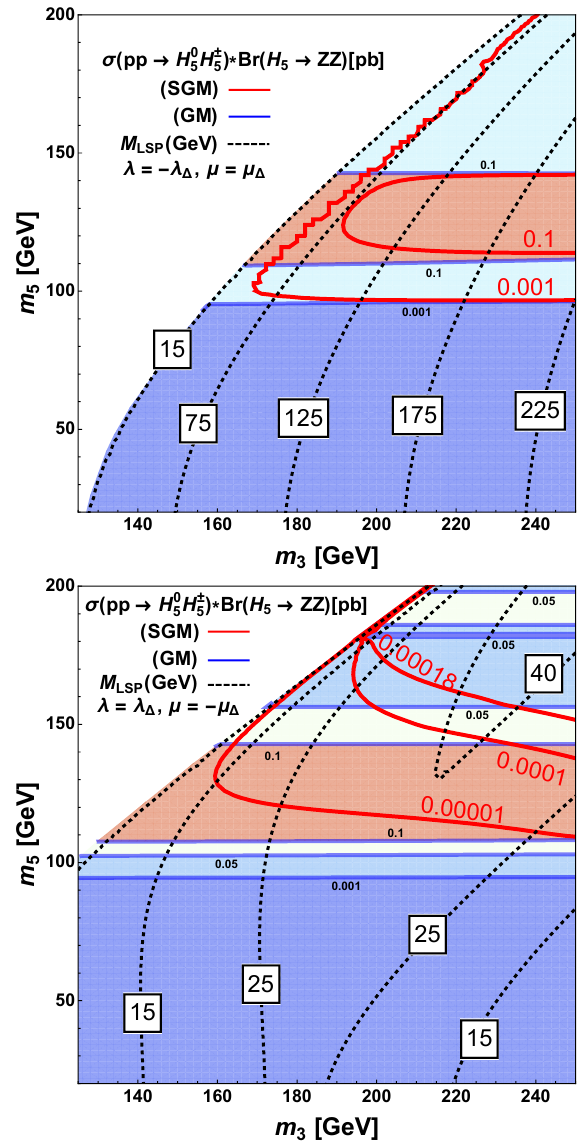
Figure 2 . Top : contours of the custodial (cid:12)veplet (pair) production cross section ( pb ) times branch- ing ratio into ZZ pairs at a 13 TeV LHC. Results for the GM model (blue solid lines with background color) and SGM model (red solid line) are shown with contours of the LSP mass (black dashed lines) and inputs de(cid:12)ned for Point 1 in eq. (3.4). Bottom : same as top, but for Point 2 in eq.